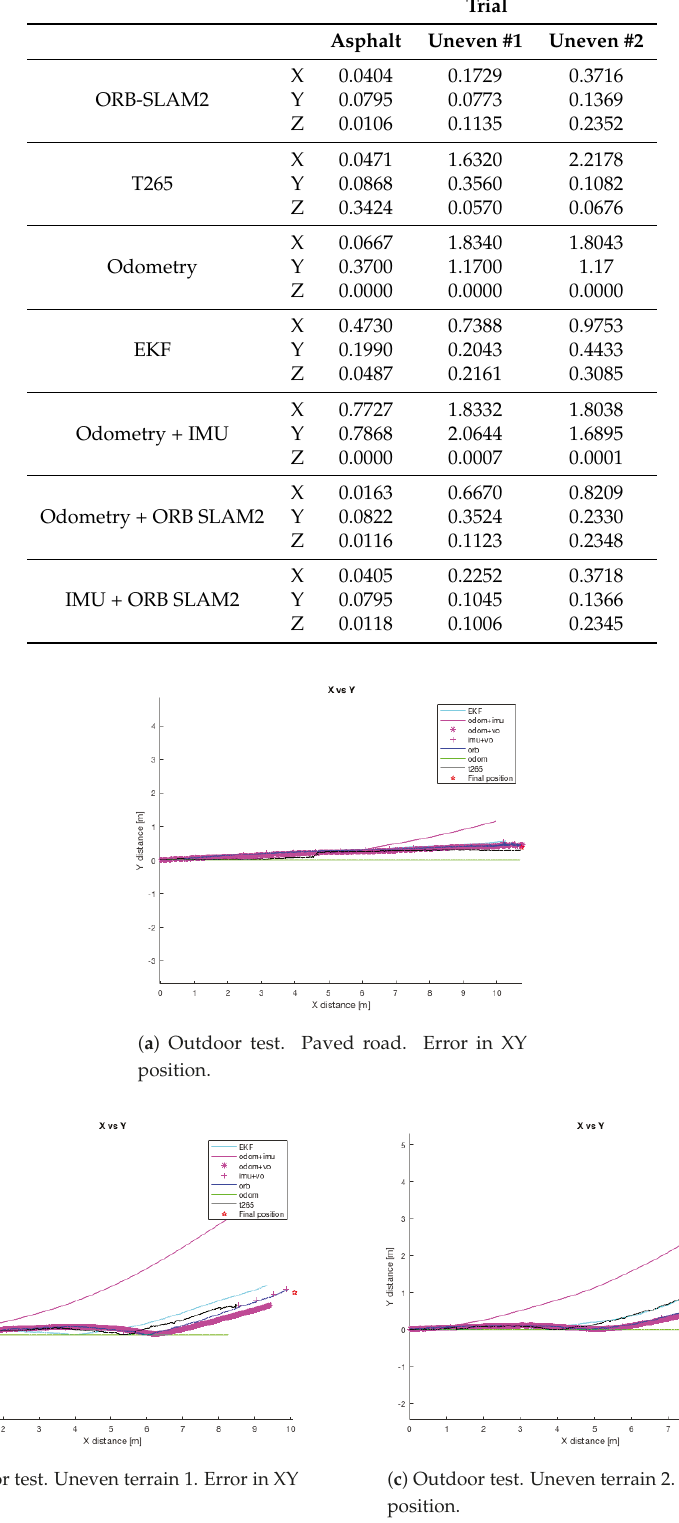
Table 15. Results for the outdoor scenario 1: Walking straight. Error units—m.